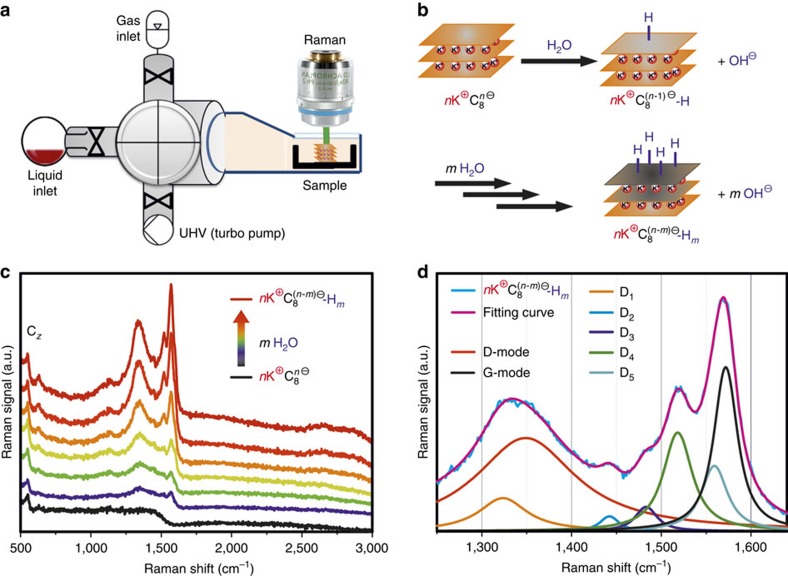
Raman setup and in situ spectroscopic monitoring of the covalent functionalization of KC8.(a) Schematic illustration of the setup for the controlled reaction of KC8 with liquid and/or gaseous reagents under ultra-high vacuum conditions. The reaction progress is monitored by in situ Raman spectroscopy. (b) Scheme of the model reaction: defect-free stage I GIC (nK+C8n−) was exposed to H2O vapour. After the initiation of the reaction, hydrogenated graphene is formed. (c) Evolution of the Raman spectra from nK+C8n− (black, bottom) to hydrogenated nK+C8(n-m)−-Hm (red, top) in the first stages of sp3 defect site formation in the crystal. (d) Raman fingerprint of nK+C8(n-m)−-Hm after addend binding and sp3 defect site formation within the graphene lattice. The D- and G-line region (1,200–1,700 cm−1) contains 7 components: graphitic E2g G mode (∼1,575 cm−1) and defect activated D mode (∼1,340 cm−1), and five additional defect modes discovered for the first time in this study, namely, D1 (∼1,325 cm−1), D2 (∼1,442 cm−1), D3 (∼1,483 cm−1), D4 (∼1,518 cm−1) and D5 (∼1,559 cm−1), that originate from carbon bond vibrational coupling deviations in the vicinity of the sp3 defect site.